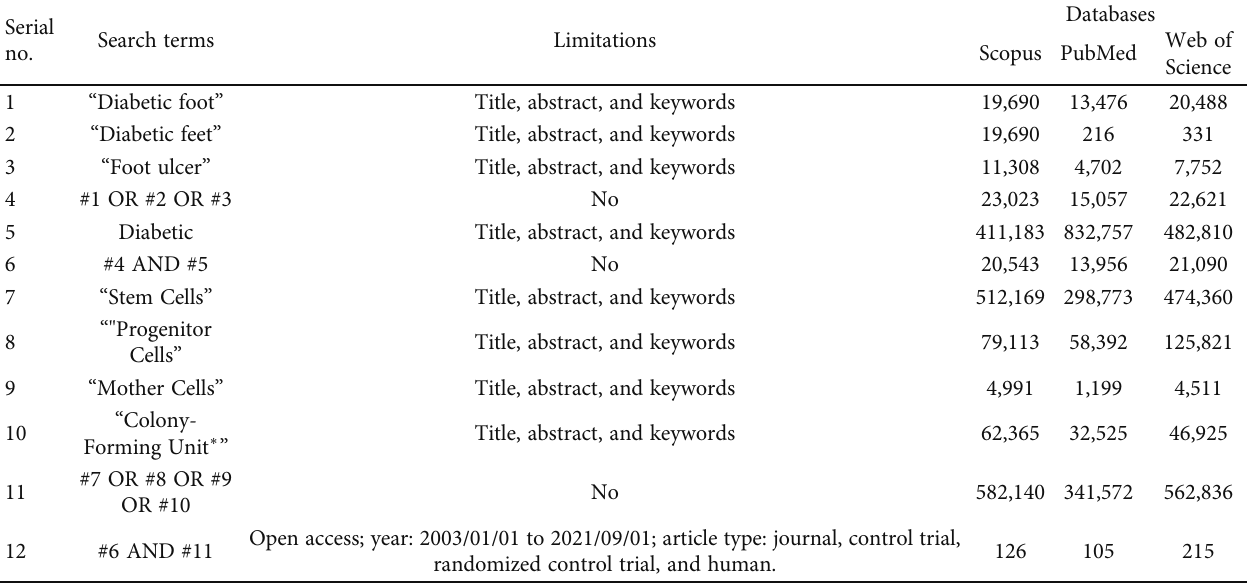
Table 1: Search strategies for study